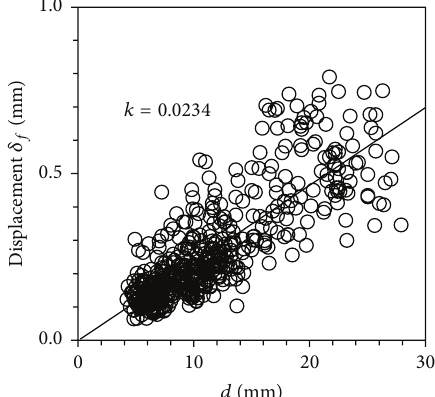
Figure 12: Relationship between 𝛿 𝑓 and 𝑑 .